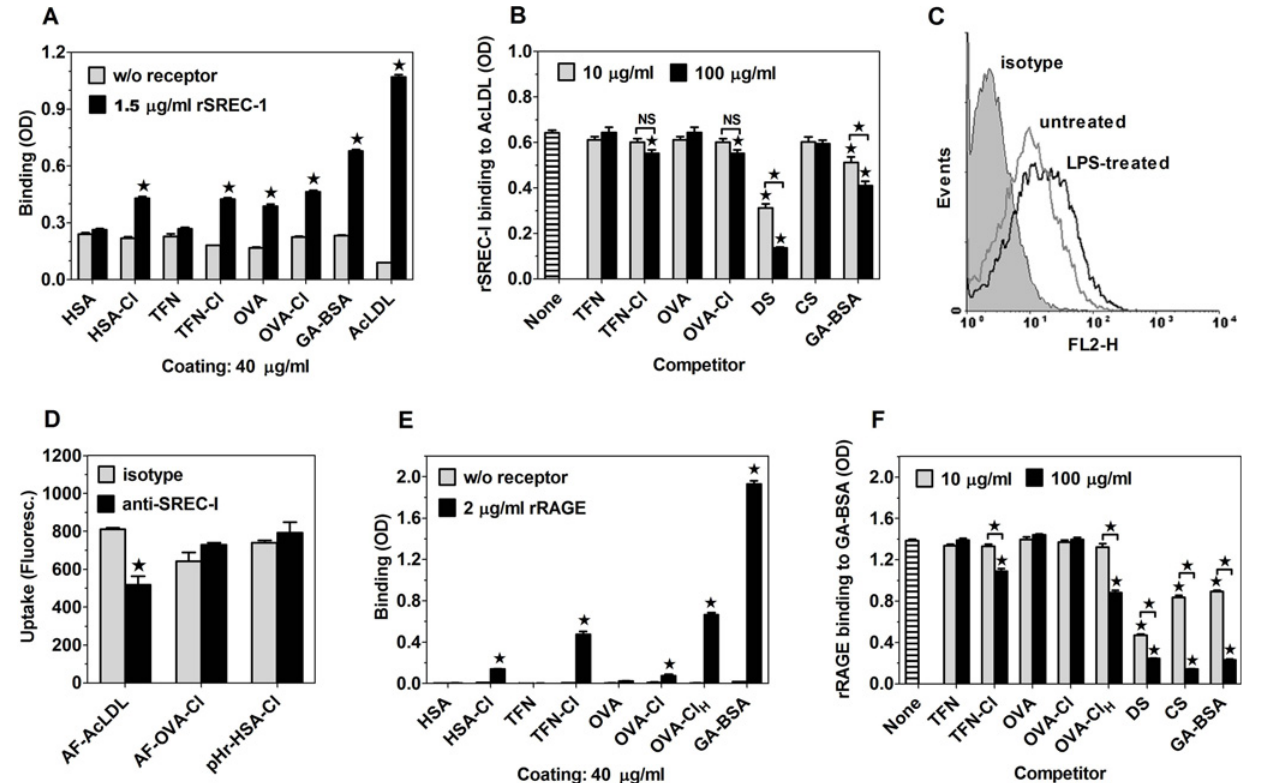
Fig 9. Both SREC-I and RAGE bind HOCl-oxidised proteins with low affinities. ( A ) Binding of rSREC-I to proteins coated onto ELISA plates. ( B ) Effects of 10 or 100 μ g/ml of indicated, soluble ligands on rSREC-I binding to plate-adsorbed AcLDL. ( C ) Binding of goat anti-mouse SREC-I Ab to untreated and LPS-pre-treated BM-DC. ( D ) Effects of polyclonal goat anti-mouse SREC-I Ab, relative to normal goat IgG, on the uptake of AF-AcLDL, AF-OVA-Cl and pHr- HSA-Cl by LPS-pre-treated, SR-A-deficient BM-DC. ( E ) Binding of rRAGE to plate-adsorbed proteins. ( F ) Effects of 10 or 100 μ g/ml of indicated, soluble ligands on rRAGE binding to plate-adsorbed GA-BSA. The data were analysed by the Student ’ s t-test (A, D, E) or by ANOVA, followed by the Tukey-Kramer post-test (B, F). * , p < 0.05; NS, non-significant.